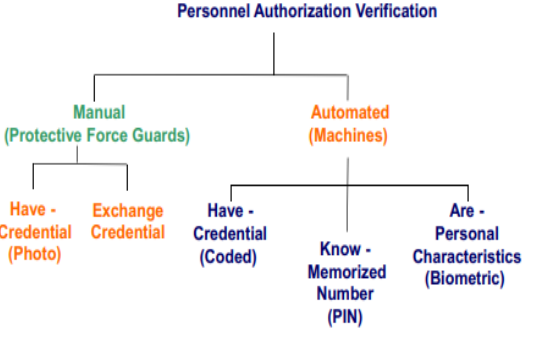
Figure 13. Example of a personnel authorization verification plan [20]